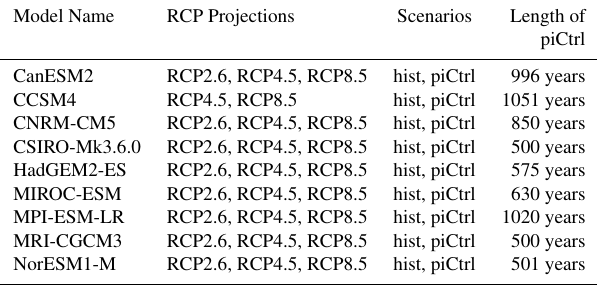
Table 1. List of the CMIP5 models and the RCP climate projections used, which cover the period from 2005 to 2100 (Moss et al., 2010) in addition to the historical scenario (“hist”, period from 1850 to 2004) and the piControl scenario (“piCtrl”). The fourth column lists the length of the piControl simulation. Note that we do not use the RCP2.6 scenario of the CCSM4 model. See also Table